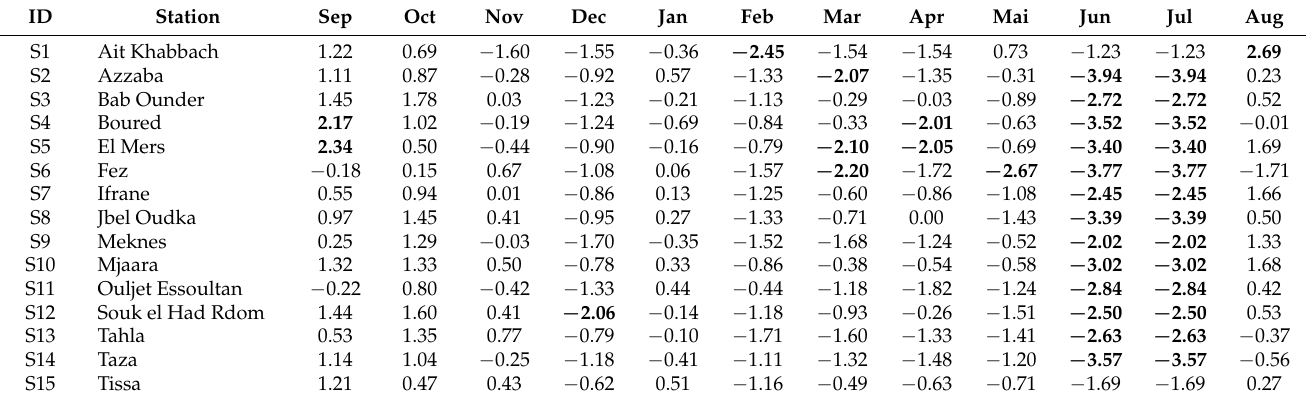
Table 3. Results of Mann – Kendall test for monthly rainfall; bold figures are significant at 95% CL.